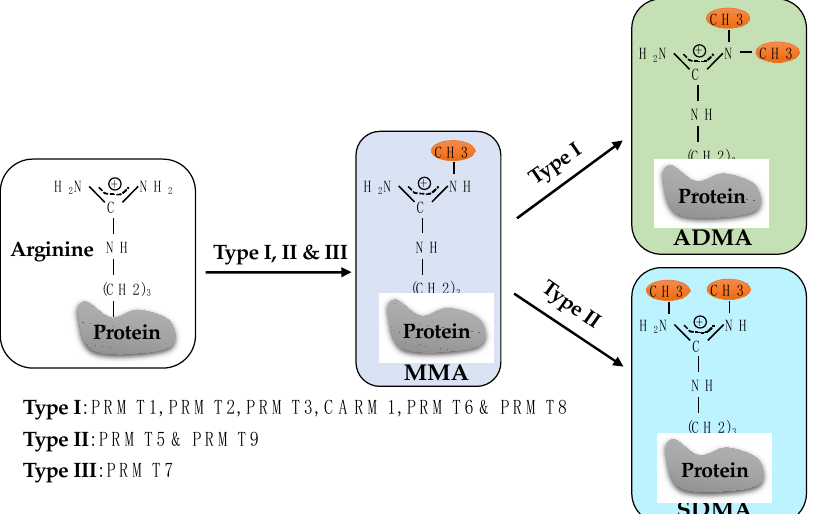
Figure 1. Three forms of protein arginine methylation, including MMA, ADMA, and SDMA, are catalyzed by nine PRMTs (Type I, II, and III). MMA, monomethylarginine; ADMA, asymmetric dimethylarginine; SDMA, symmetric dimethylarginine.